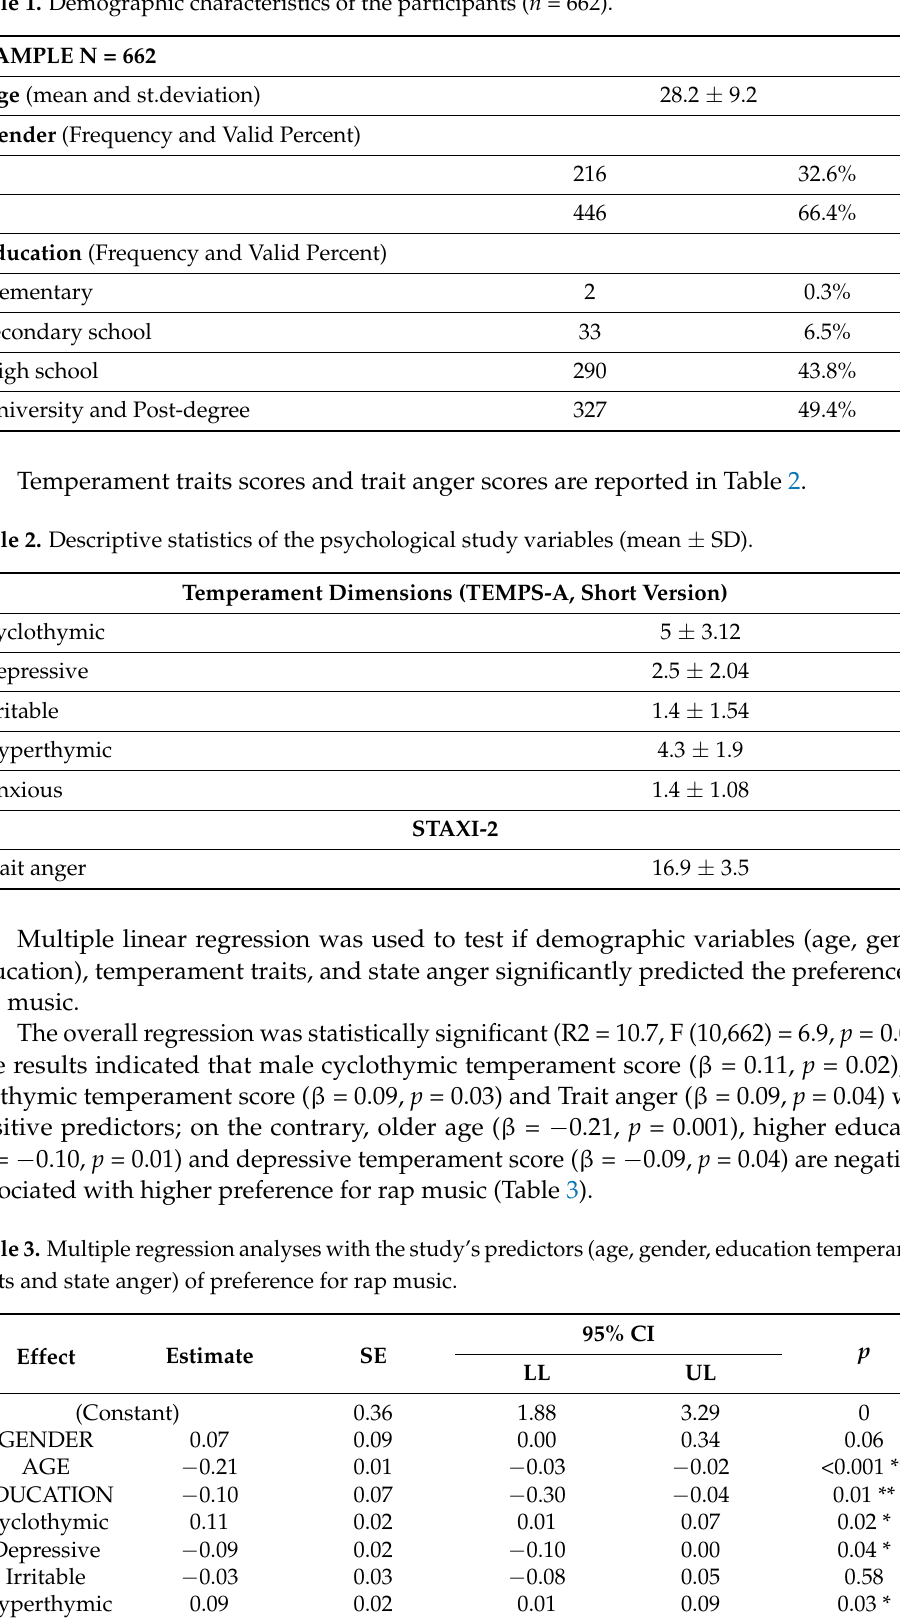
Table 1. Demographic characteristics of the participants ( n = 662).